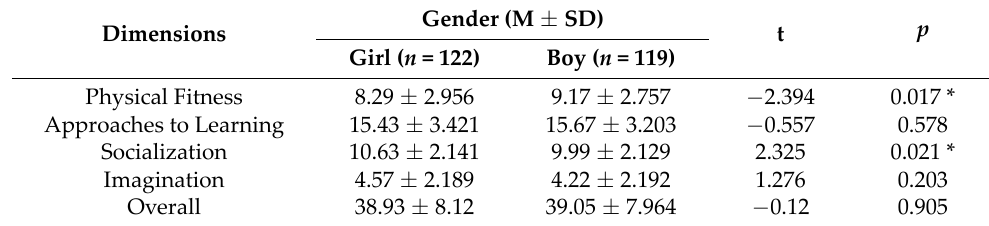
Table 5. Boys’ and Girls’ Performance in Outdoor Free